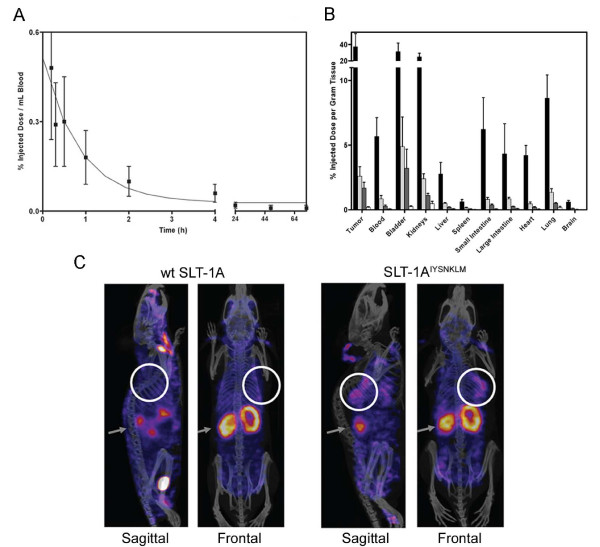
In vivo blood clearance rate and tumor-targeting of 125I-SLT-1AIYSNKLM (A) Blood clearance of 125I-SLT-1AIYSNKLM shown as percentage of injected dose per mL blood collected at various time points over a 72 h period post-i.v. injection. The clearance rate (t1/2) of 125I-SLT-1AIYSNKLM was shown to be ~11 min. (B) Biodistribution per collected gram of wet tissue of 125I-SLT-1AIYSNKLM after 1 h (black bars), 6 h (light grey bars), 12 h (dark grey bars) and 24 h (white bars) post-i.v. administration. (C) Tumor localization of 125I-SLT-1AIYSNKLM versus wt 125I-SLT-1A (negative control) as shown by nanoSPECT and CT imaging. The composite images show the tissue uptake of the radiolabeled proteins (as pink colored areas) as well as the location of tumor xenografts (white circles) and that of kidneys (grey arrows).